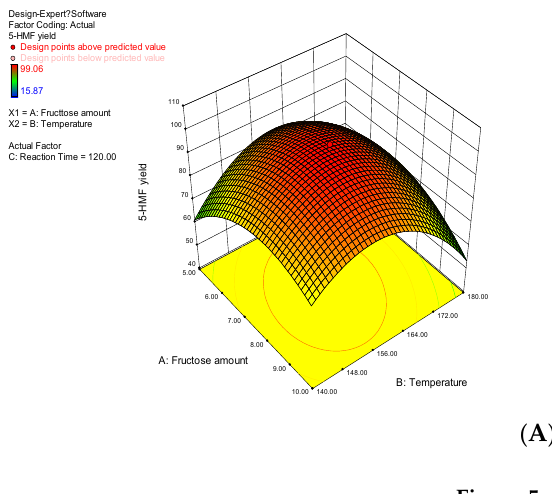
Figure 5 . Cont . Figure 5.